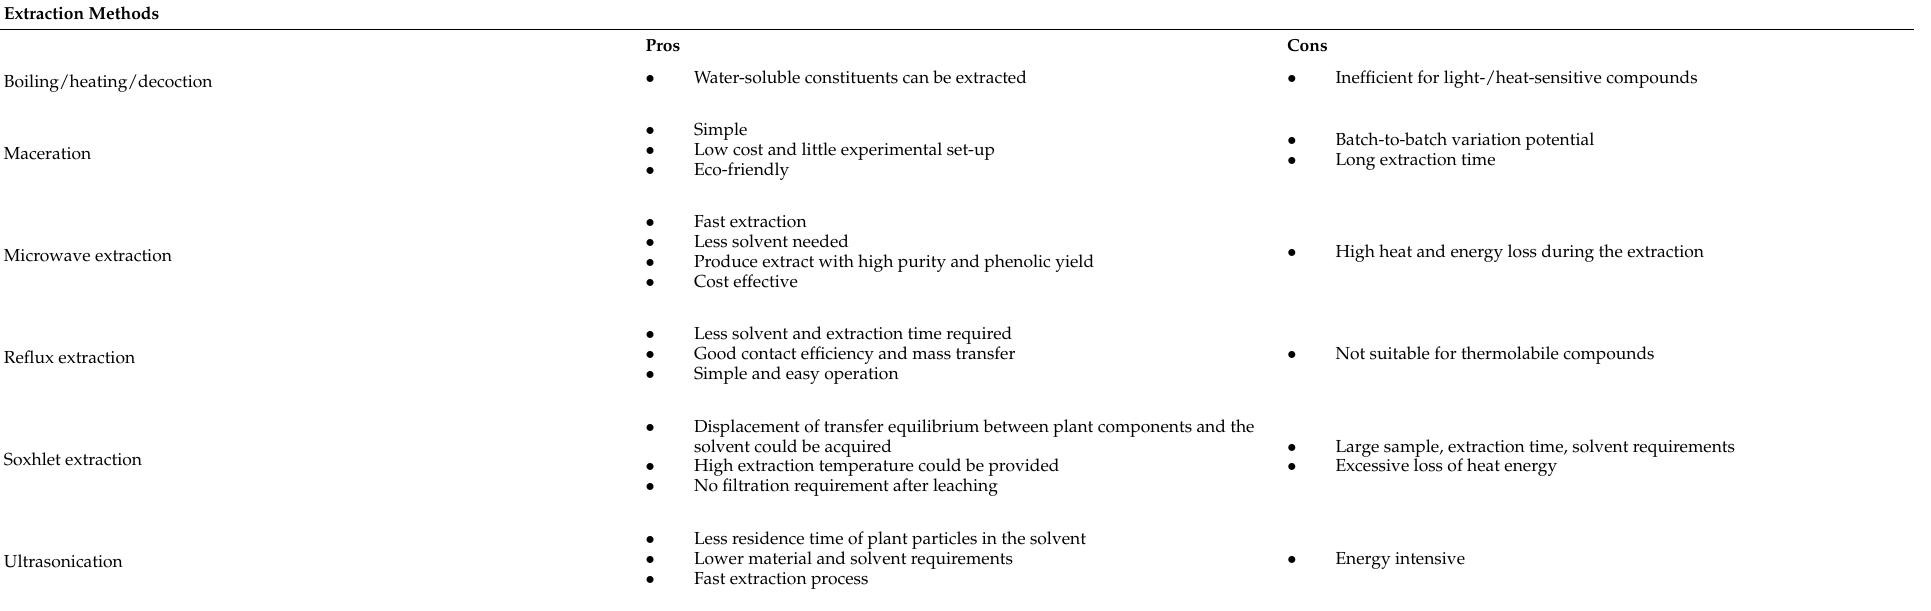
Table 2. Pros and cons of various plant extraction